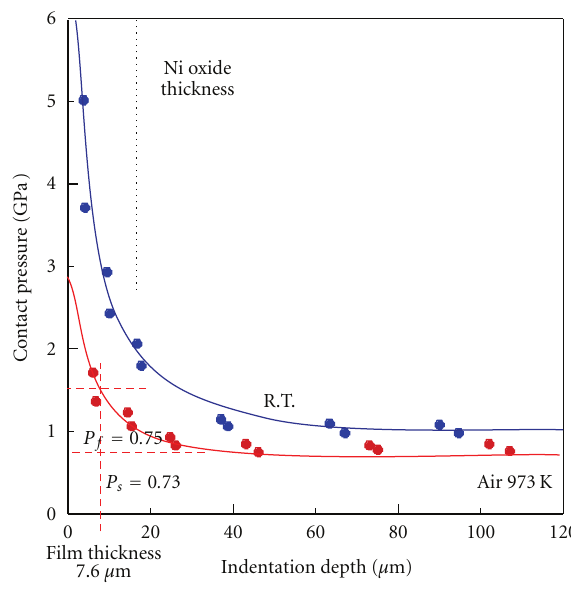
Figure 14: Contact pressure versus indentation depth curves for nickel specimens at R.T. and 973K.